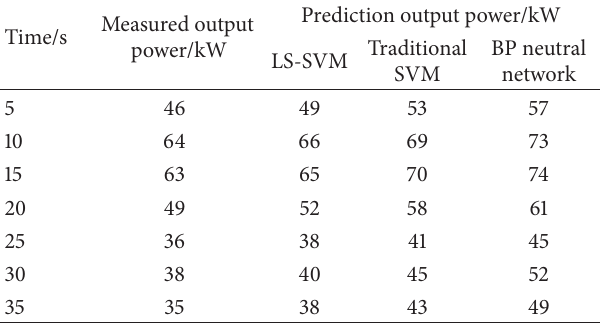
Table 2: Output power prediction results of the hydraulic excavator based on different prediction